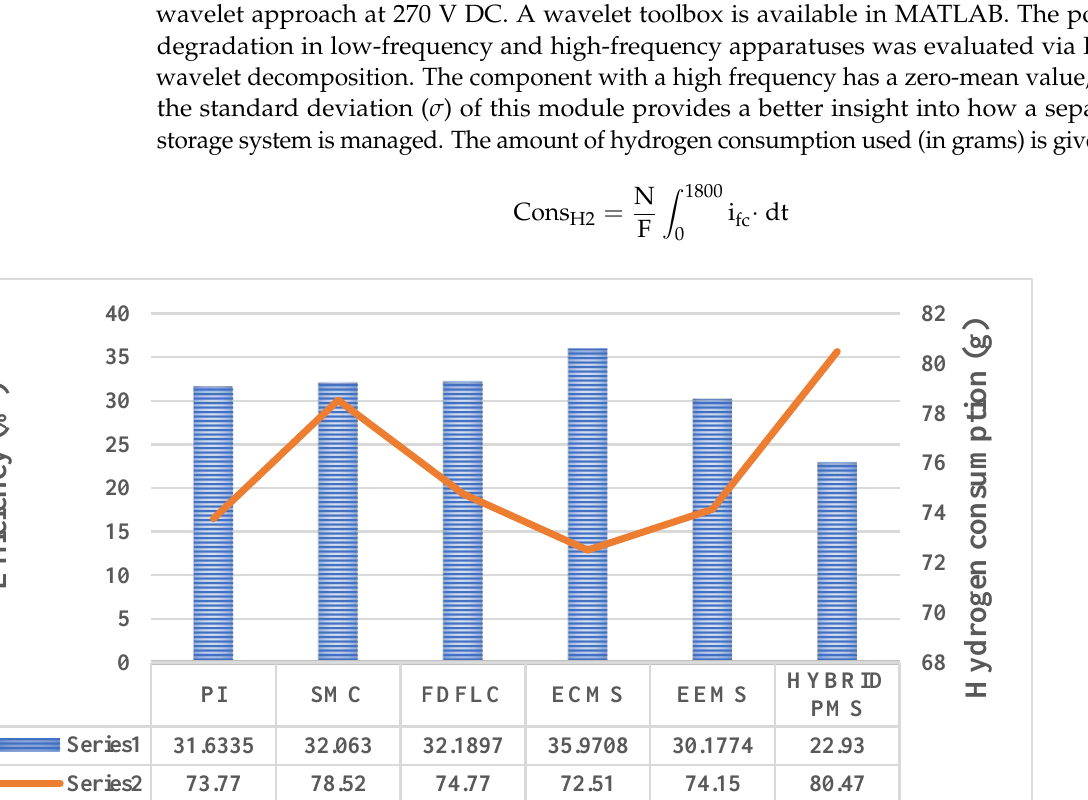
battery and supercapacitor energy, the stress assessment was performed using the Haar